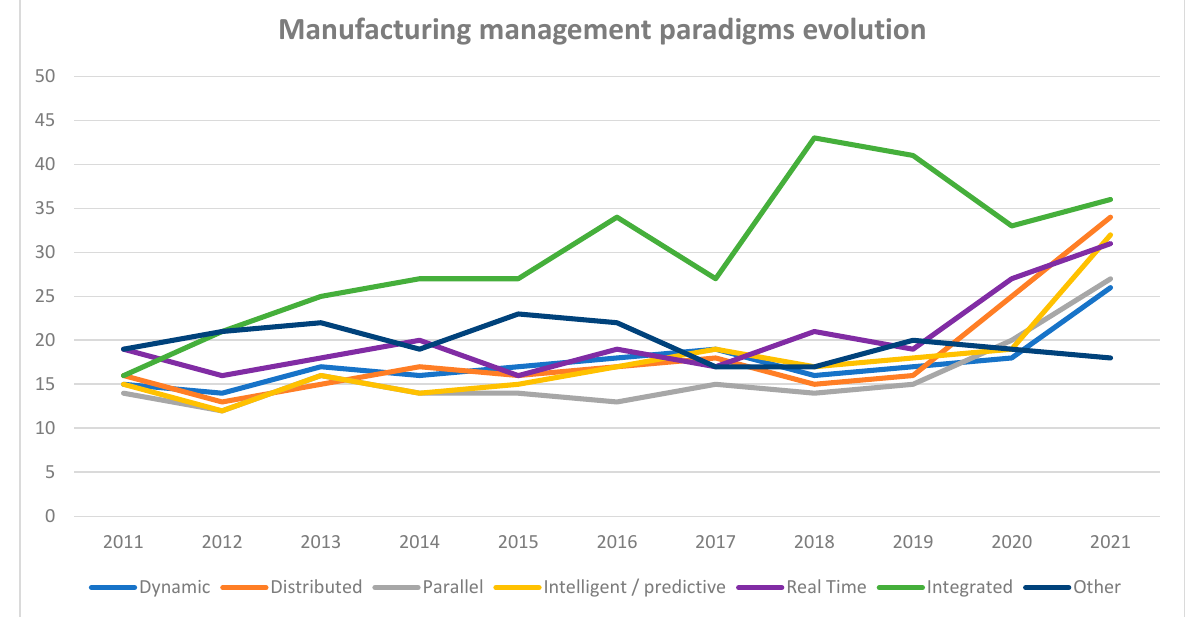
Figure 2. Total amount of publications about management paradigms from 2011 to 2021.